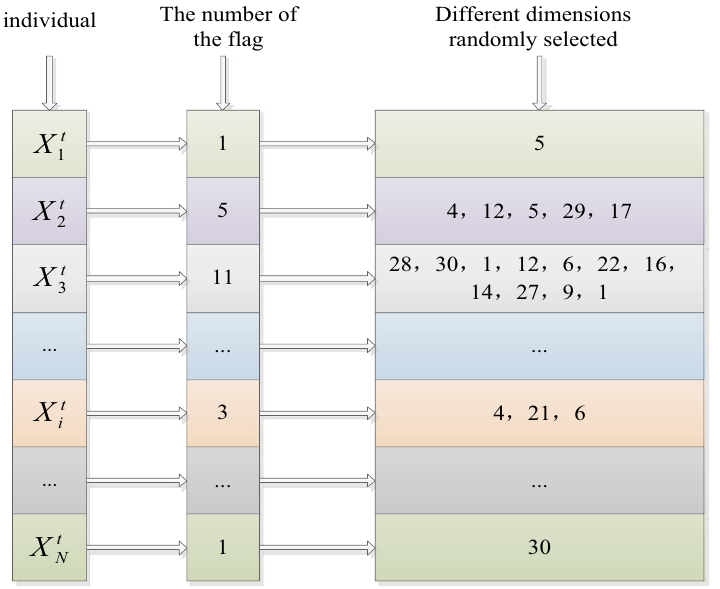
Figure 3. Dimension selection in subspace search